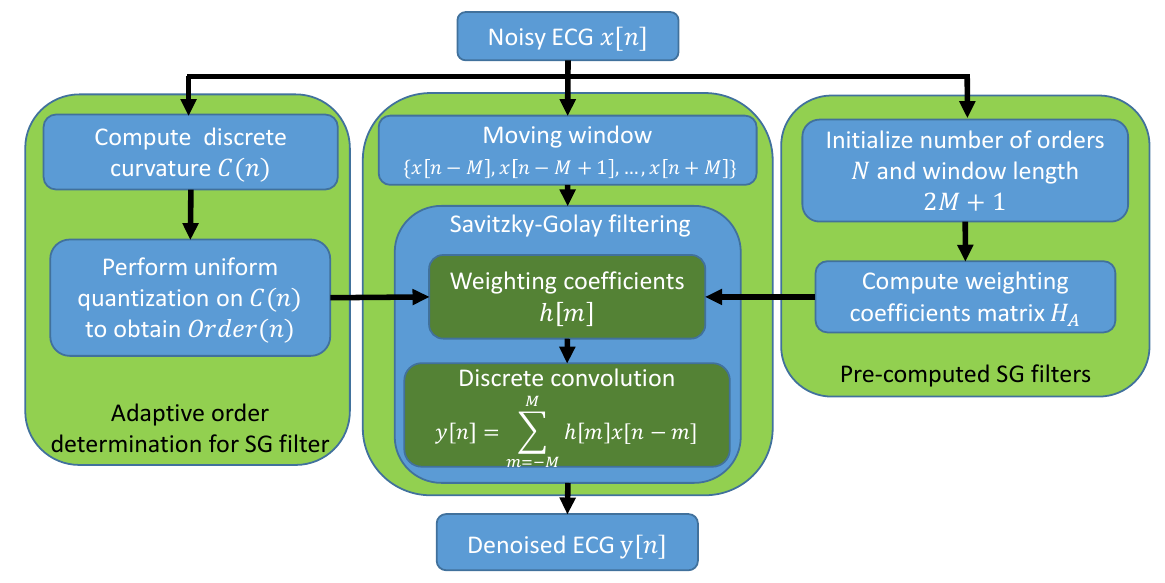
Figure 2. System architecture of the proposed LDASG filter for ECG signal